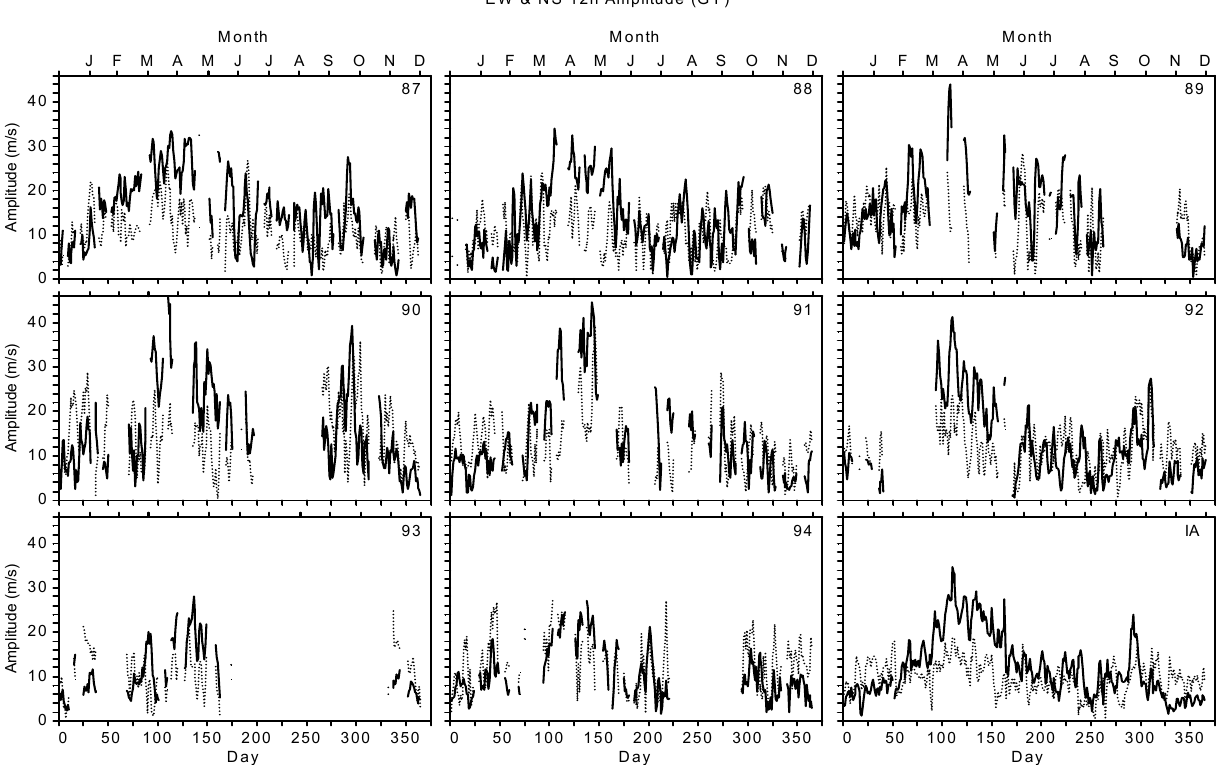
Fig. 2. The zonal (solid line) and the meridional (dotted line) amplitudes of the semidiurnal tide for the years 1987–1994 and for the corresponding 8-year interannual average (IA) for